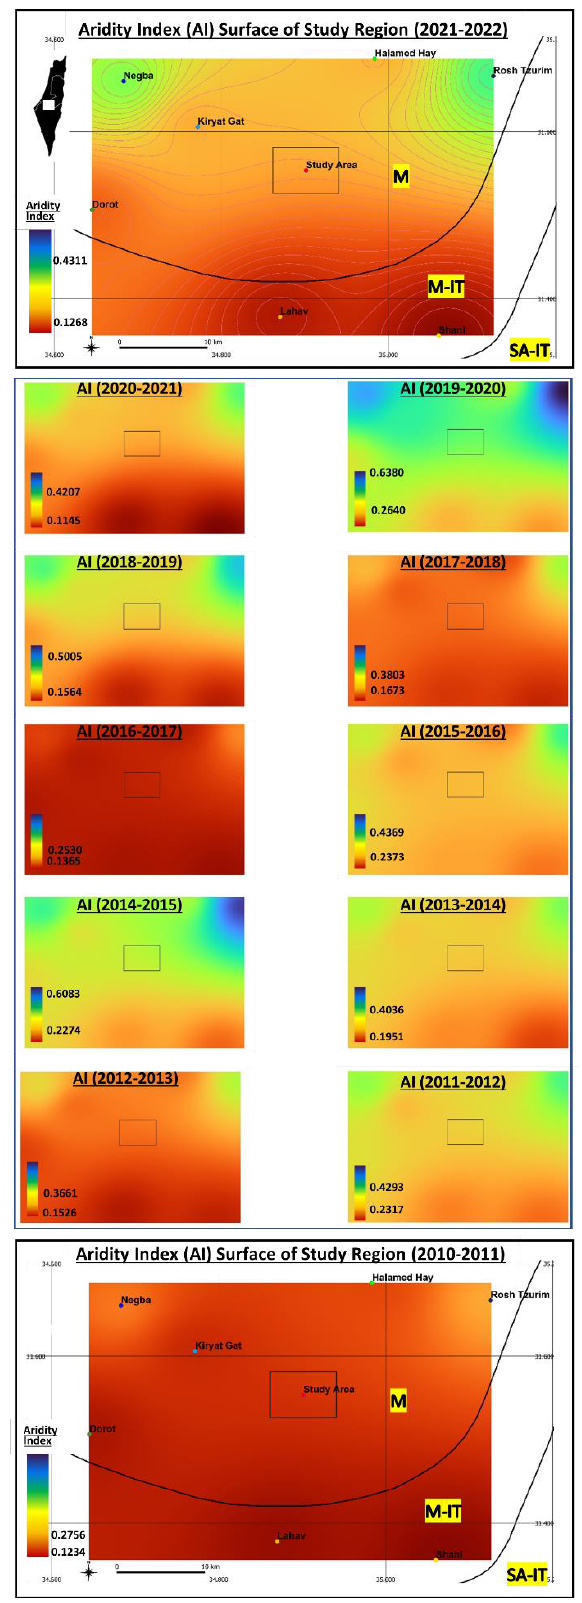
Figure 3. The study area (rectangle) within larger regional chorotype-aridity context derived from interpolation analysis in GIS. Chorotypes M, IT and SA and their combinations after Danin and Orshan (1999: 16) phytogeographical